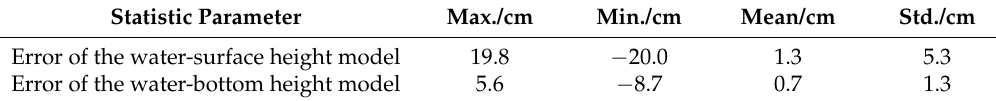
Table 7. Statistical parameters of the water-surface height and water-bottom height model errors.